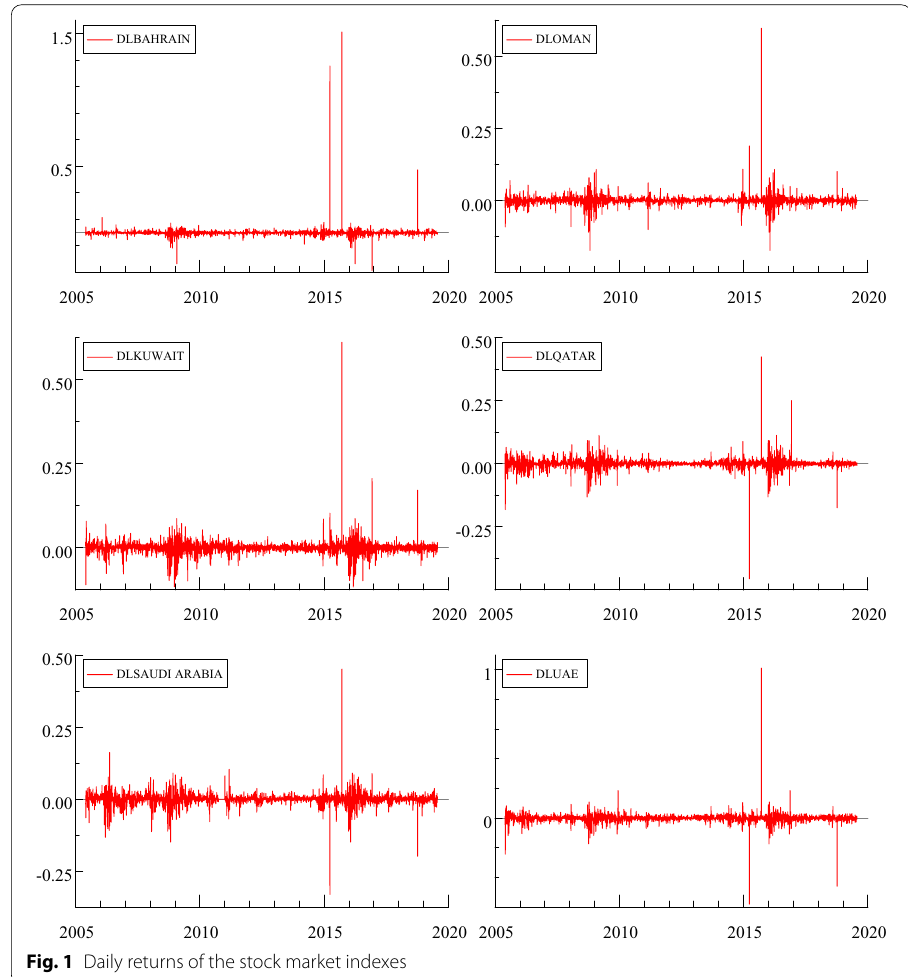
Fig. 1 Daily returns of the stock market indexes